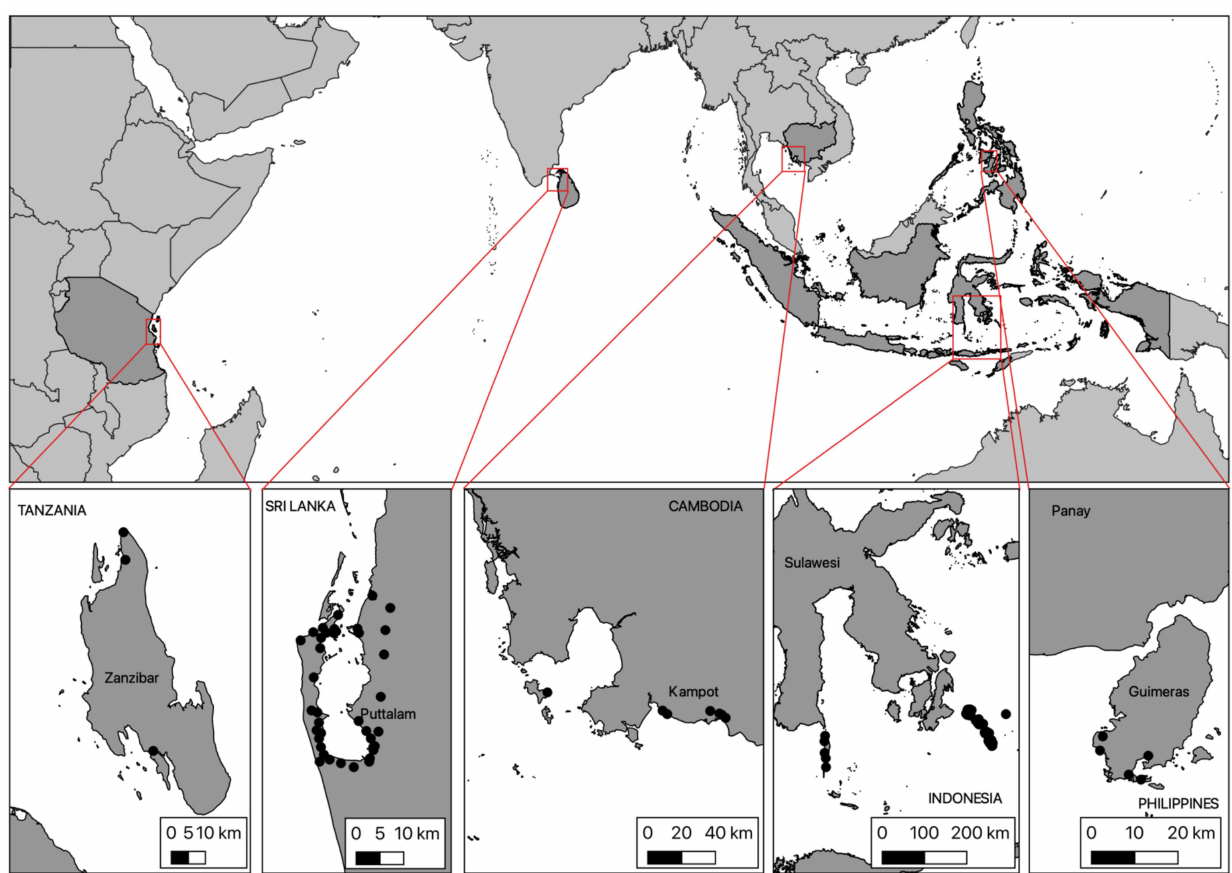
Figure 1. Map indicating the five countries in which household surveys were conducted within the Indo-Pacific region. Points (black circles) represent unique